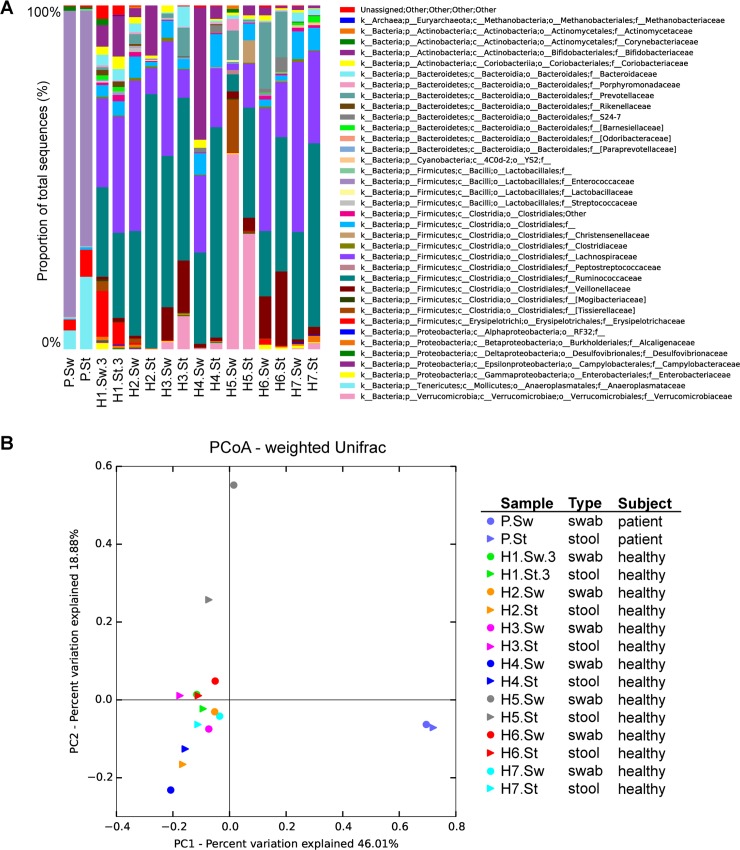
Comparison of stool- versus swab-derived microbiota profiles.(A) Taxonomic profiles at the family level. The legend has the same color direction as in the bar plots. (B) Beta-diversity calculated as weighted Unifrac and visualized by principal coordinate analysis (PCoA). P–patient; H–healthy volunteer; Sw–swab; St–stool.